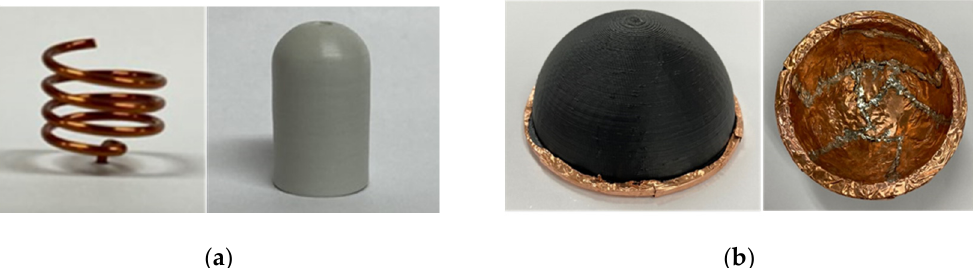
Figure 7. Illustration of ( a ) normal-mode helical antenna and capsule-shaped insulation layer, ( b ) hemisphere-shaped radiation shield.